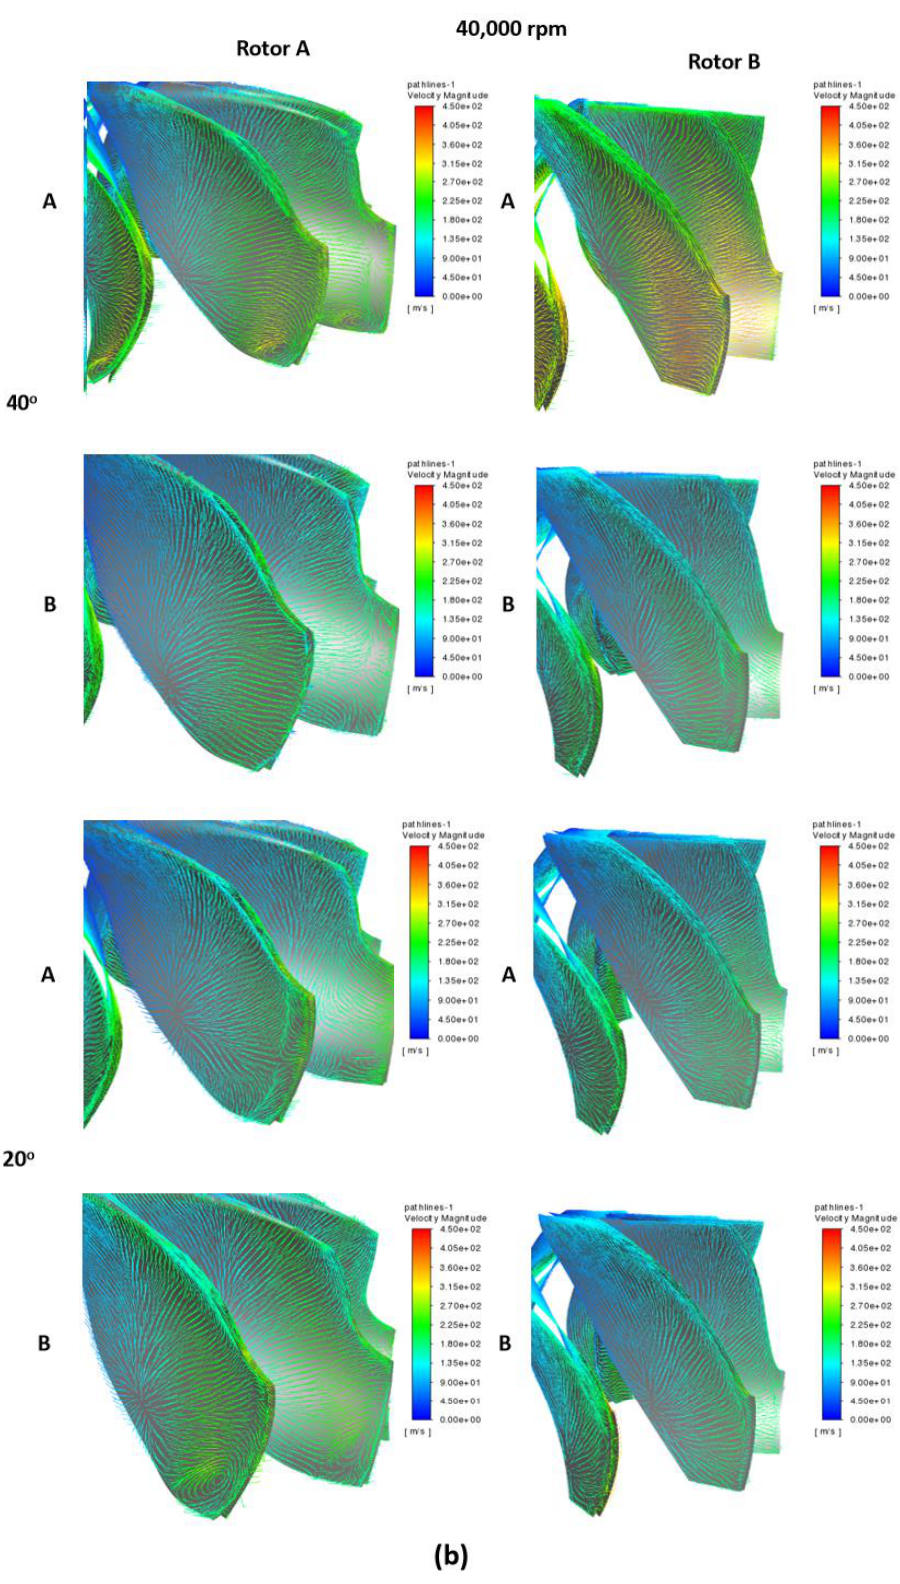
Figure 35. The first-stage rotor velocity streamlines for two different rotor geometries, VTG positions, A and B operating conditions and at the ( a ) 60,000 rpm and ( b ) 40,000 rpm turbine speed. The velocity streamlines of the second-stage rotor are shown in Figure